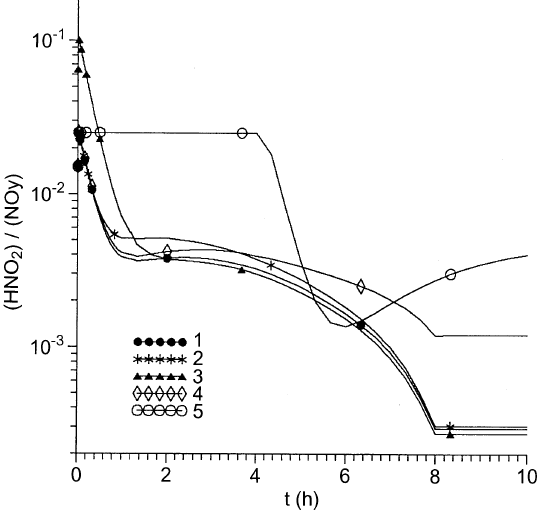
Fig. 7. Time evolution of NO ( solid lines ) and NO (cid:120) ( dashed lines ) relative to NO (cid:121) contents in the plume box model over their back- grounds for B midday emission in FC and for variants with: (cid:49) , basic plume; (cid:50) , wide plume; (cid:51) , basic plume with five times increased emission of OH: (cid:52) , basic plume in clean air; (cid:53) , midnight basic injection in the flight corridor